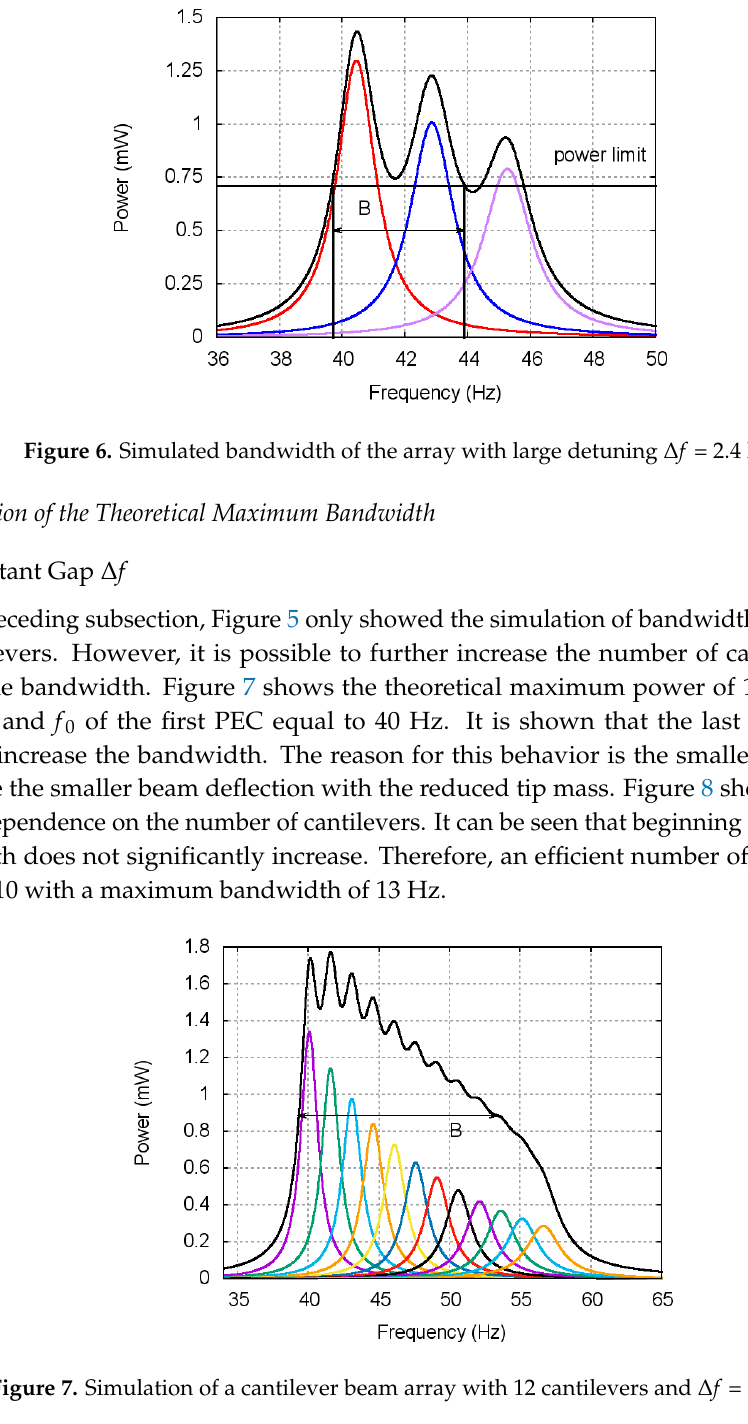
Figure 8. Simulation of bandwidth dependence on the number of cantilevers for ∆ f = 1.5 Hz. The lines connecting theoretical points serve as a guide for the eye. The above observation can be made for various ∆ f . Figure 9a shows the dependence of the “effective” number of cantilevers (this means that the bandwidth does not significantly increase with an additional cantilever) on ∆ f . It can be seen that if ∆ f is decreasing, more cantilevers can be used, but the total bandwidth (see Figure 9b) improves only slowly. A further interesting aspect is that, although the number of cantilevers is increased and ∆ f is reduced, the bandwidth does not exceed a value of about 15 Hz. This means that the mass tuning is rather limited and a wide frequency spectrum cannot be achieved by mass tuning alone.